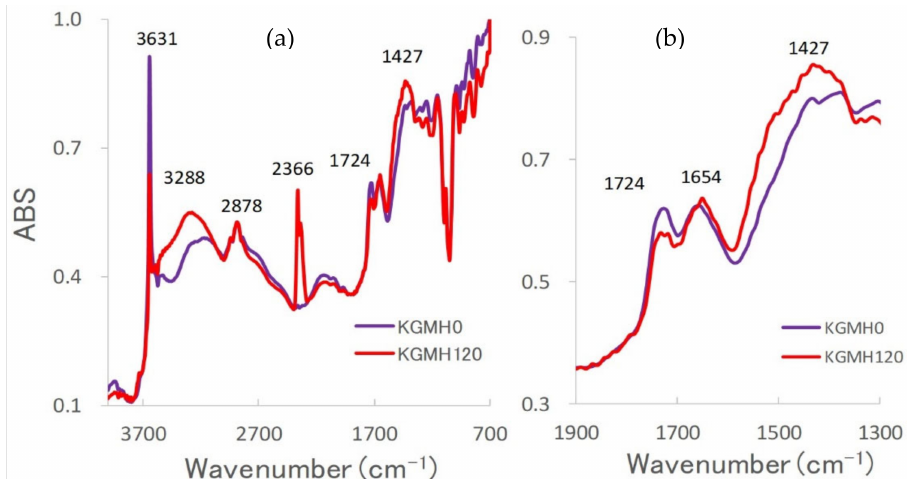
Figure 3. Fourier-transform infrared spectra of the KGMH mixtures ground for various grinding times. ( a ) Spectral range: 4000–700 cm − 1 ; ( b ) spectral range: 1900–1300 cm − 1 .